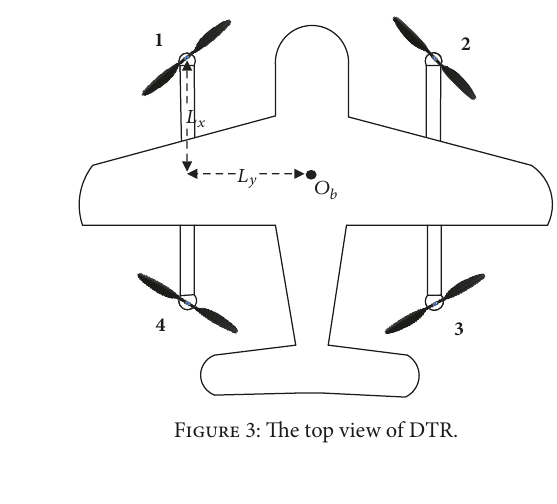
Figure 3: The top view of DTR.